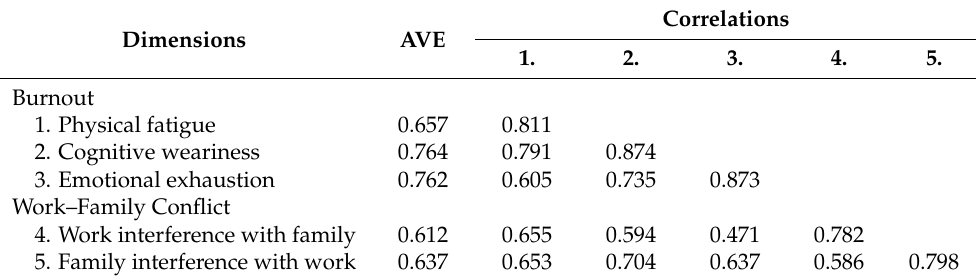
Table 4. Convergent and discriminant validity